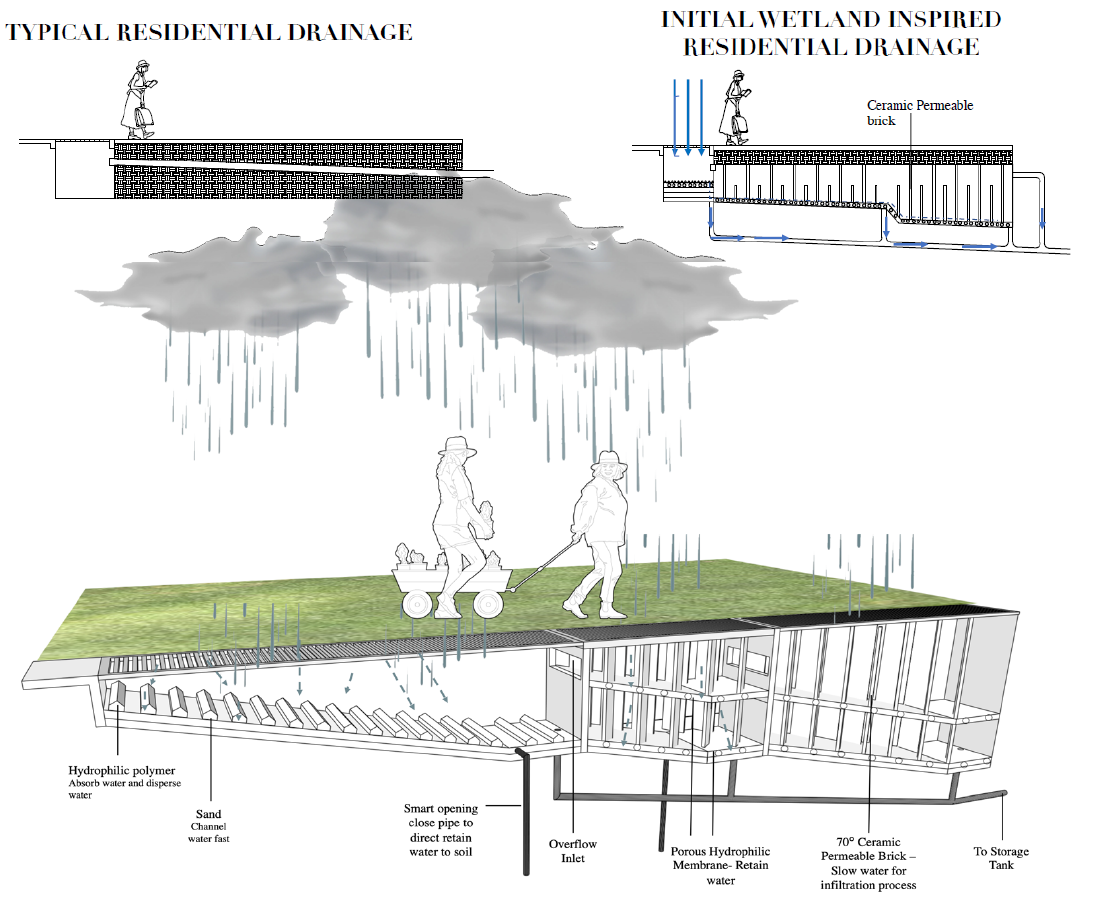
Figure 8. Comparison of typical residential drainage and the wetland inspired drainage to retain water and avoid flooding in residential buildings. Illustration: [28].